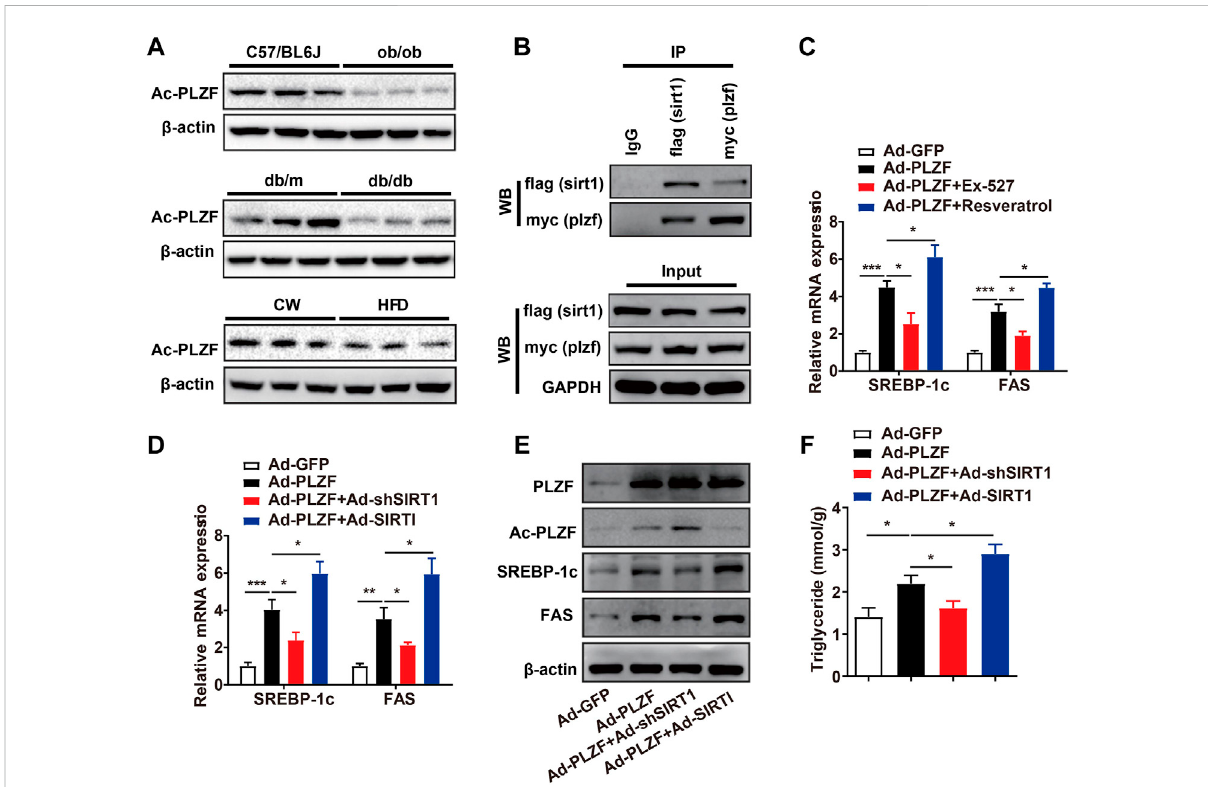
FIGURE 4 HepaticPLZFincreaseslipogenesis,whichisdependentoninteractionwithSIRT1. (A) TheacetylationlevelofPLZFintheob/ob,db/db,andDIO mice, and corresponding littermate controls. (B) Co-IP assay showing that PLZF interacts with SIRT1 in the primary hepatocytes. (C,D) qPCR analysis of lipogenic genes, including SREBP-1C and Fas with indicated treatment in the primary hepatocytes. (E) Western blot analysis of acetylation level of PLZF as well as expression of lipogenic genes in the primary hepatocytes with indicated treatment. (F) TG content in the primary hepatocytes treated with indicated treatment. N = 4 – 6/group. The data shown are the means ± SEM. * p < 0.05, ** p < 0.01, *** p < 0.001. EX-527, SIRT1 inhibitor. Resveratrol, SIRT1